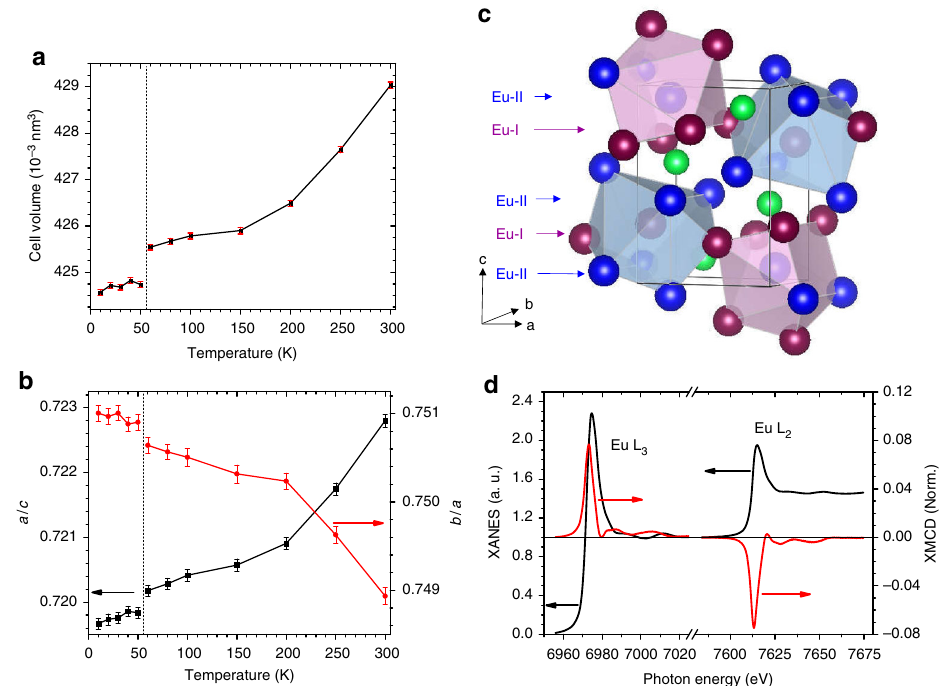
Fig. 4 Crystal structure and Eu electronic con fi guration in Eu 2 In. a Unit cell volume ( V ), b ratio c / a and b / a of the lattice parameters, determined from powder x-ray diffraction as function of the temperature. The error bars represent the standard deviation estimated during the re fi nement of the lattice parameters. c Schematic representation of the crystal structure. d X-ray absorption near edge spectroscopy (XANES) and normalized magnetic circular dichroism (XMCD) spectra at Eu L 2,3 edges at T = 5 K and B = 3